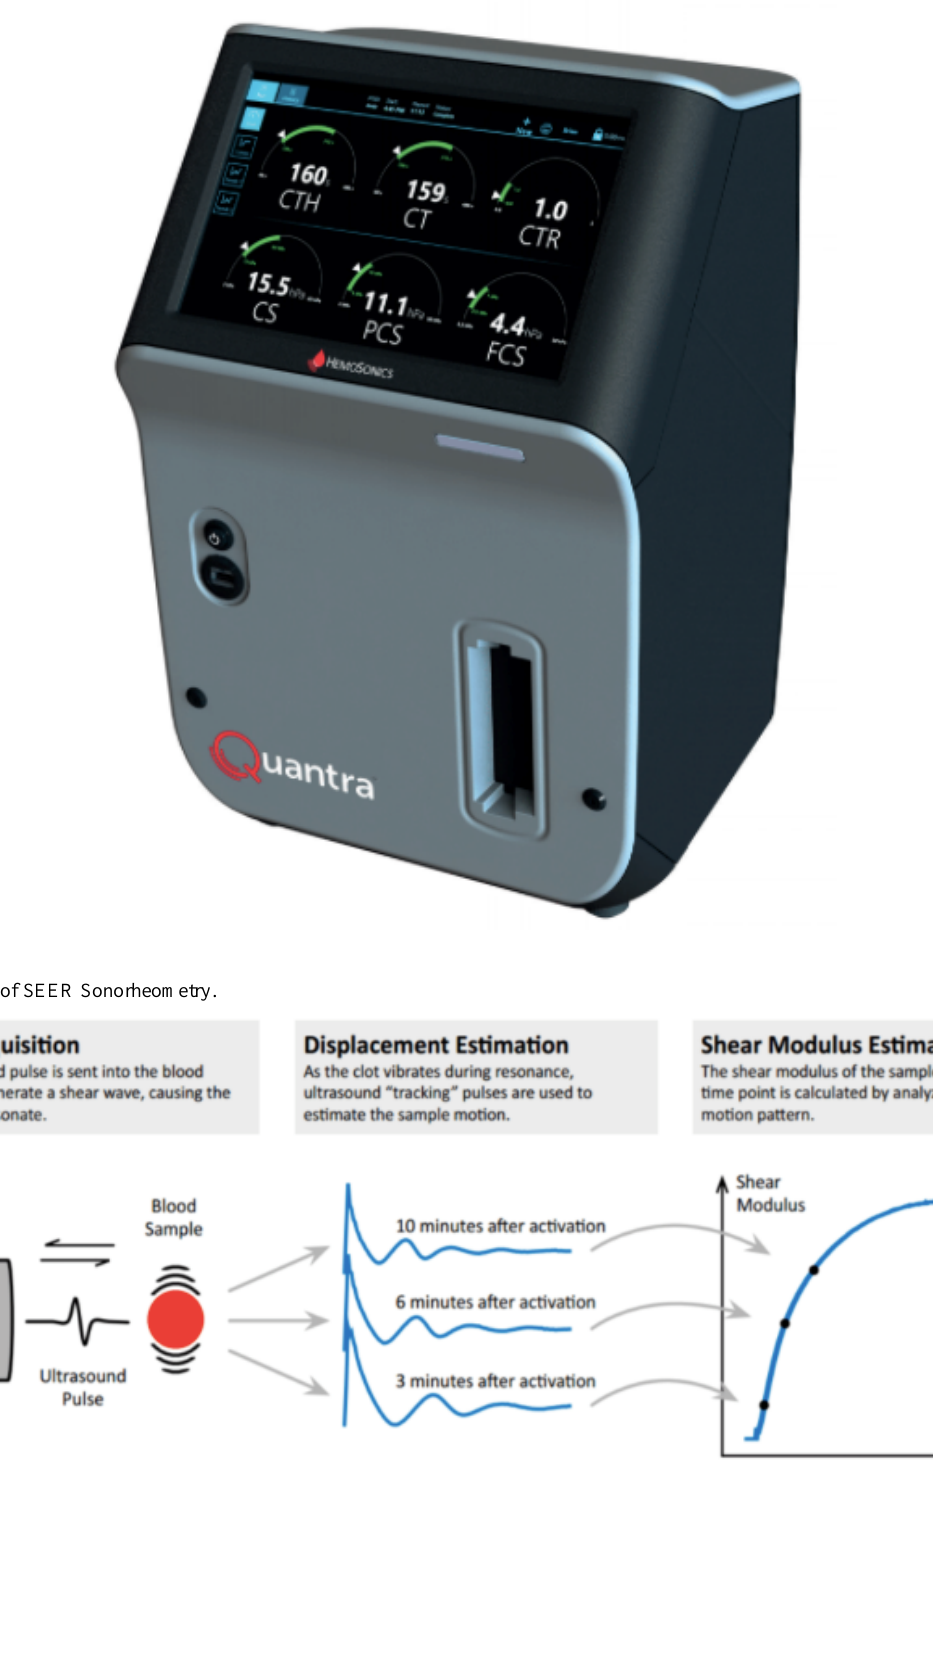
Figure 1. Quantra Analyzer. CS: clot stiffness; CT: clot time; CTH: heparinase clot time; CTR: clot time ratio; FCS: fibrinogen contributions to clot stiffness; PCS: platelet contributions to clot stiffness.